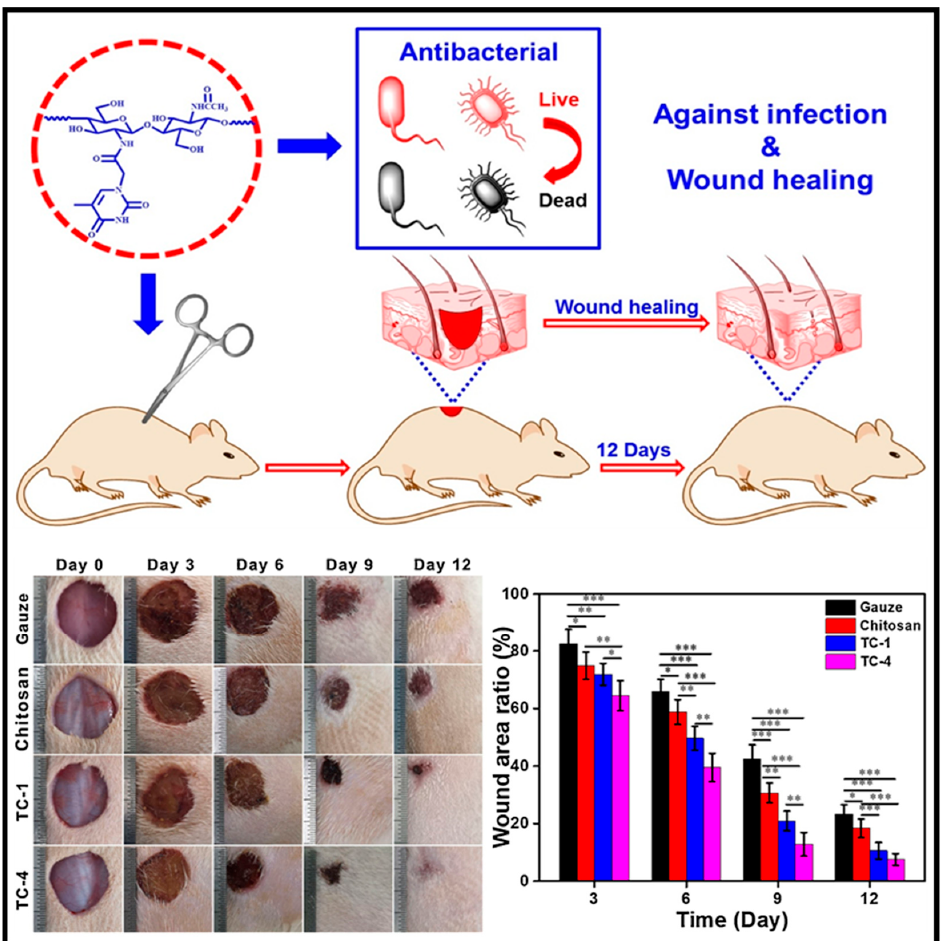
Figure 14. This figure represents the application of hydrogels against infected wounds on mice model. Representational photographs of the healing progress of the wounds covered with gauze, and the sponges of chitosan, adopted from [78] with permission from Elsevier through copyright clearance center.